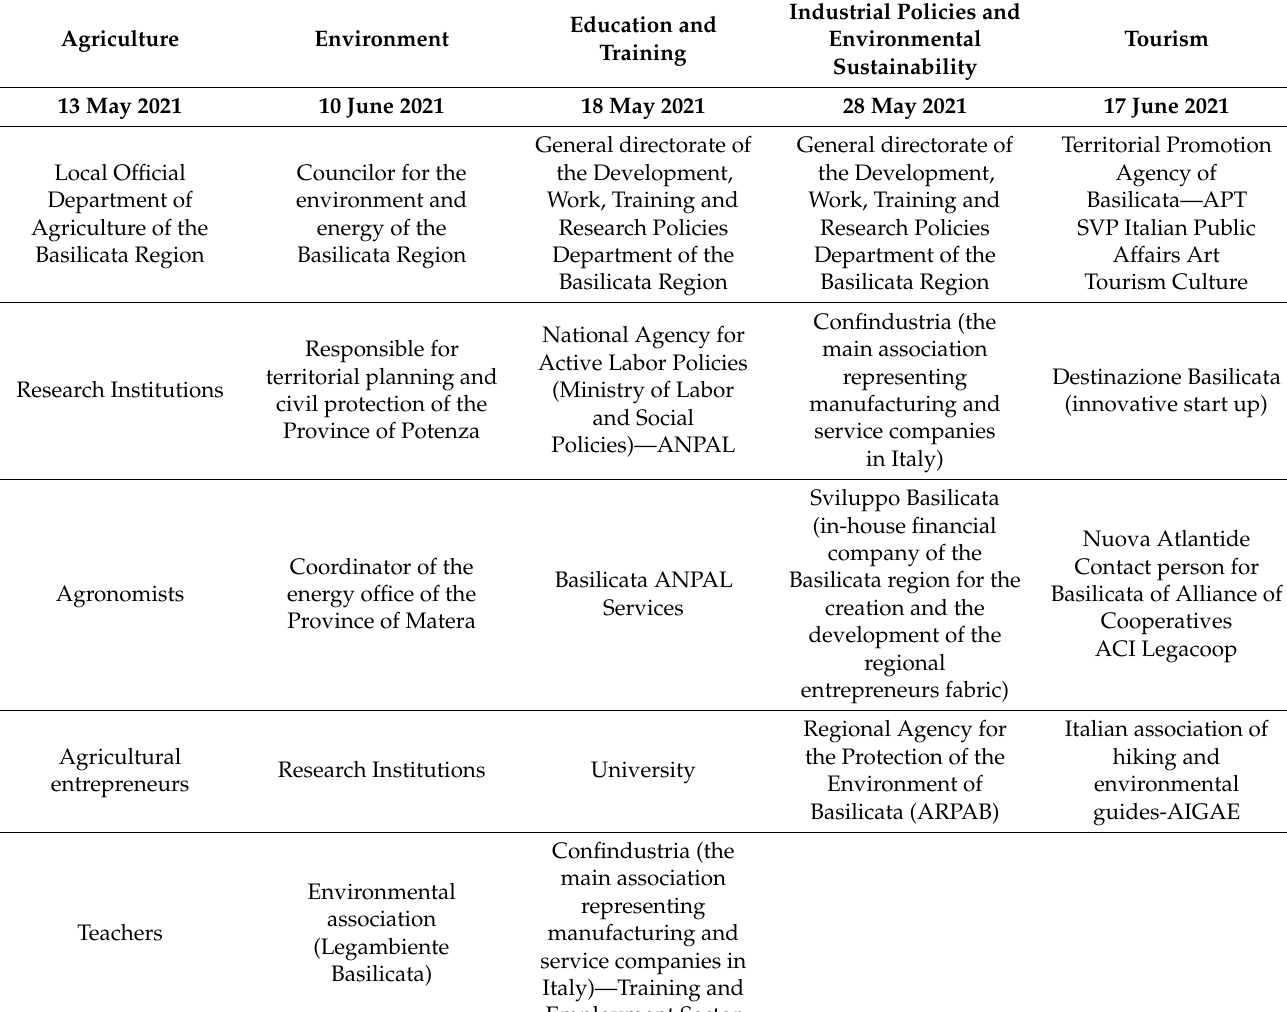
Table 6. List of participating institutions and experts divided by focus